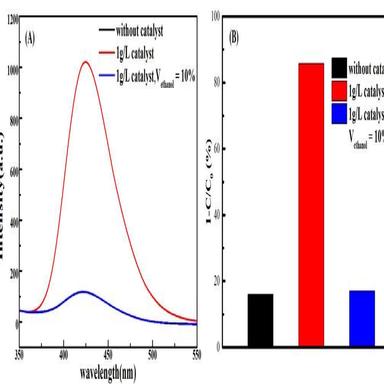
Variation of ultrasonic-irradiated PL spectra (A) and sonocatalytic degradation efficiency after 30 min (B) under conditions: without catalyst, with 1 g/L catalyst, and with 1 g/L catalyst containing ethanol (Vethanol 10%).